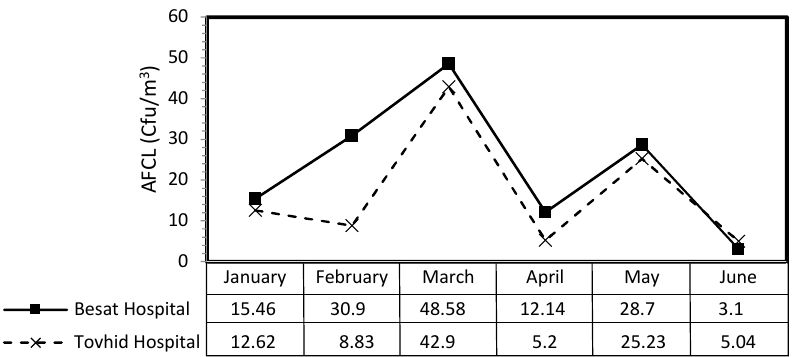
Fig. 4. Air fungal contamination load (AFCL) in two hospitals during the